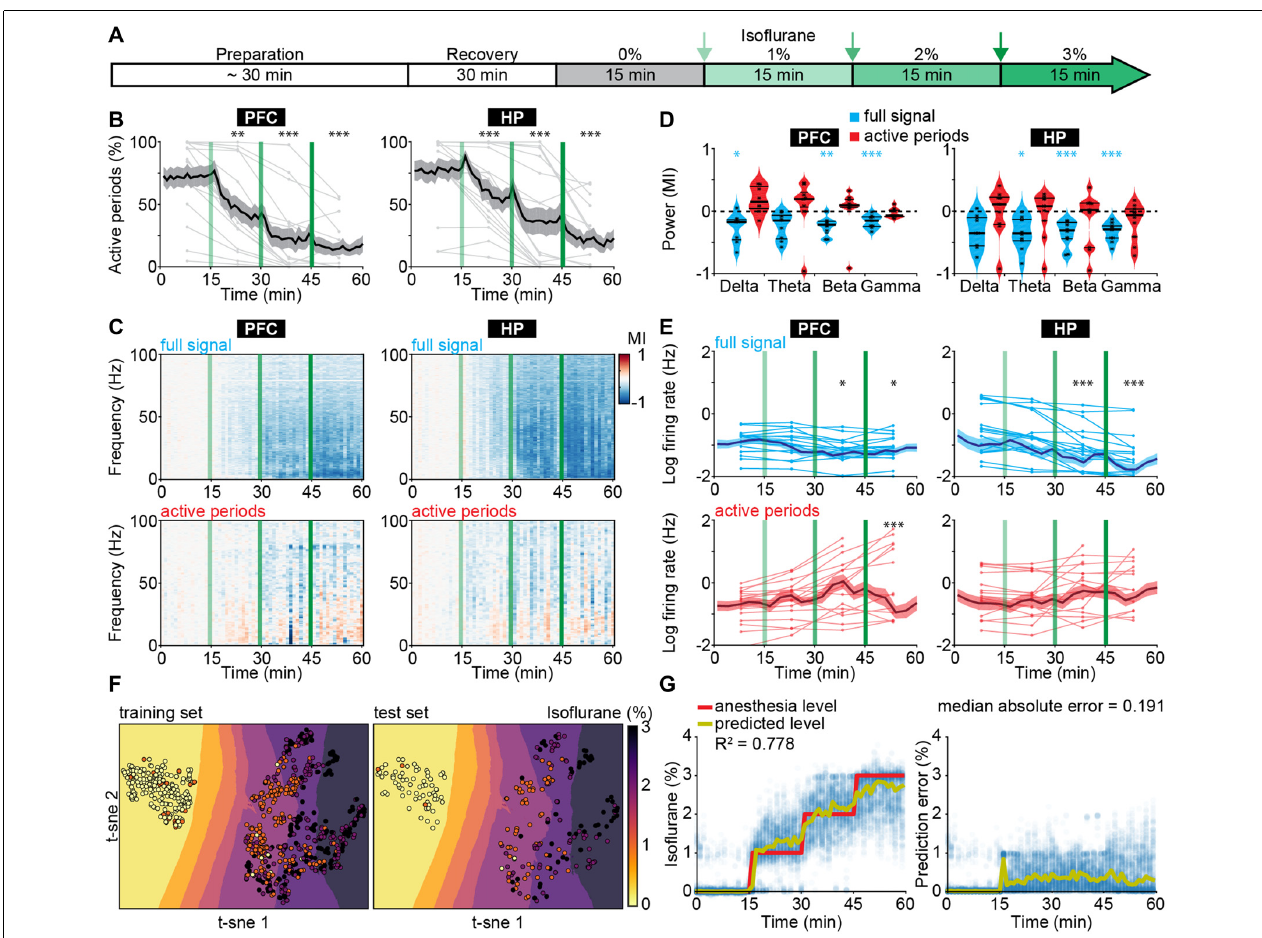
FIGURE 2 | Suppression of active periods in relationship with the depth of isoflurane anesthesia in neonatal mice. (A) Schematic representation of experimental protocol for LFP recordings without anesthesia and during increasing levels of isoflurane anesthesia in neonatal mice (P8–10). (B) Line plots displaying the relative occurrence of active periods in PFC and HP during increasing levels of isoflurane anesthesia. (C) Color-coded MI of power spectra for full signal (top) and active periods (bottom) during increasing levels of isoflurane anesthesia. (D) Violin plots displaying the MI of power in delta (2–4 Hz), theta (4–12 Hz), beta (12–30 Hz) and gamma (30–100 Hz) frequency bands for full signal (blue) and active periods (red). (E) Line plots displaying MUA firing rates during full signal (blue) and active periods (red). In (B,C,E) green lines correspond to the time points of increasing isoflurane anesthesia. (F) Visualization of anesthesia depth prediction by t-sne plots. Background color codes for predicted anesthesia depth, while the color of the dots represents the actual anesthesia level in the training (left) and test set (right). (G) Scatter plots displaying anesthesia depth predictions with support vector regression (left) and absolute errors between anesthesia depth prediction and actual anesthesia depth (right).